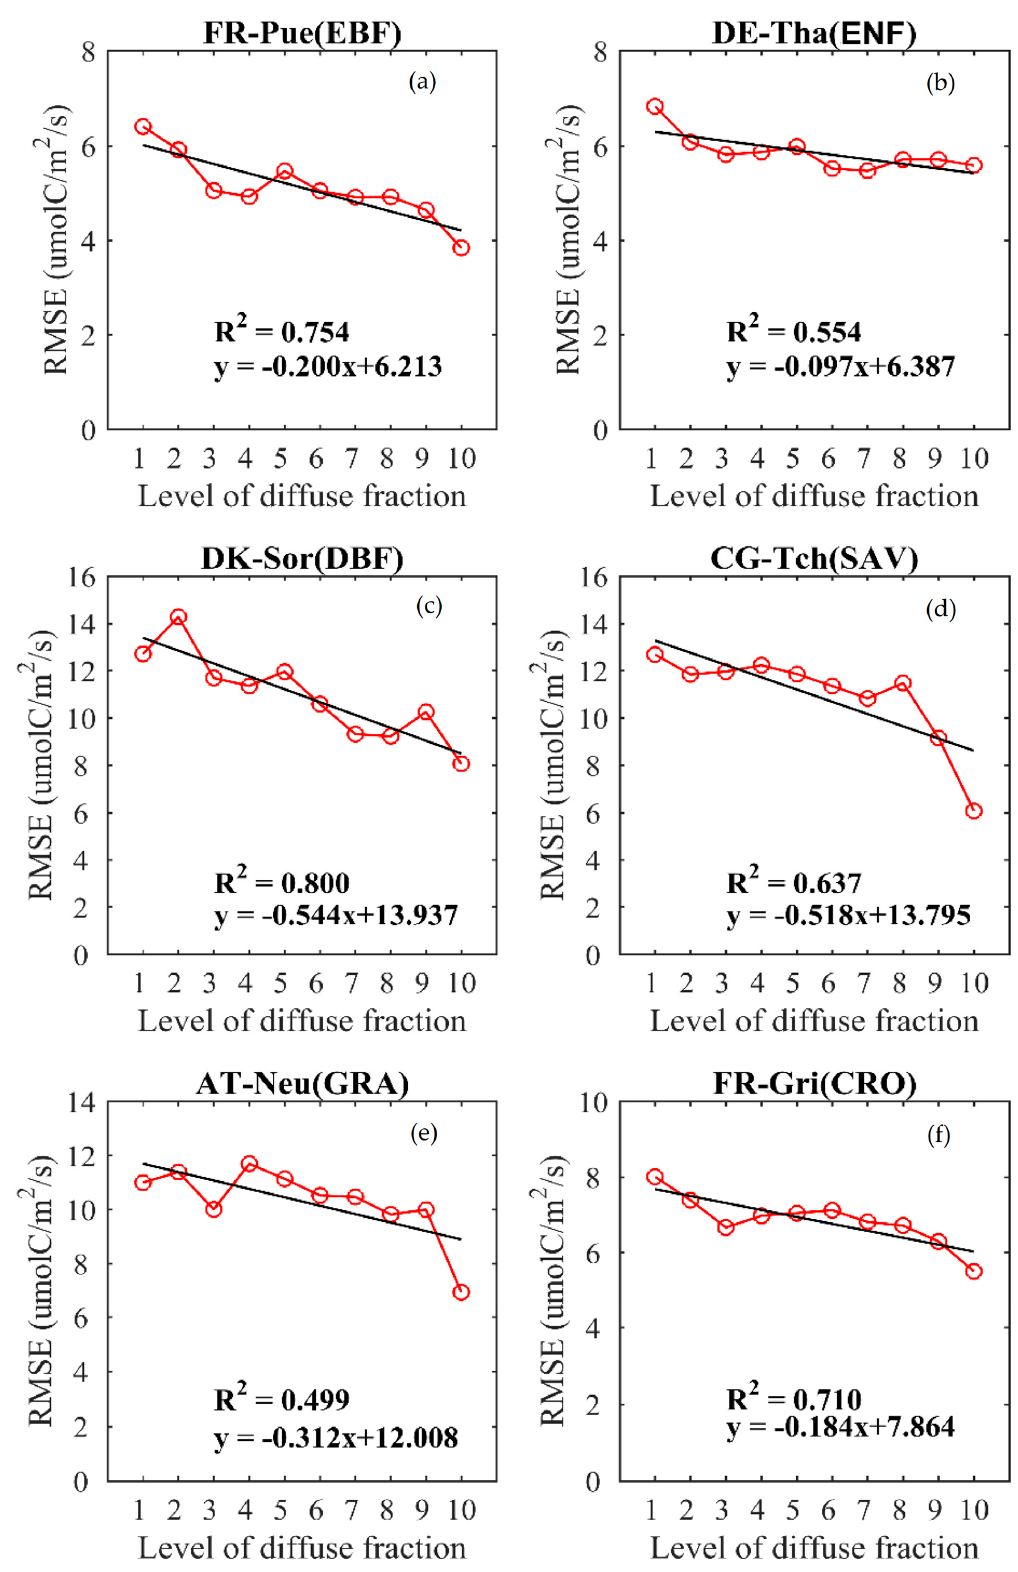
Figure 5. RMSE variations between the DDA-based GPP and observed GPP under different levels of diffuse fraction in different vegetation types: ( a ) EBF; ( b ) ENF; ( c ) DBF; ( d ) SAV; ( e ) GRA, and ( f ) CRO (The level of diffuse fraction denotes the values of diffuse fraction varying from 0 to 1 with 0.1